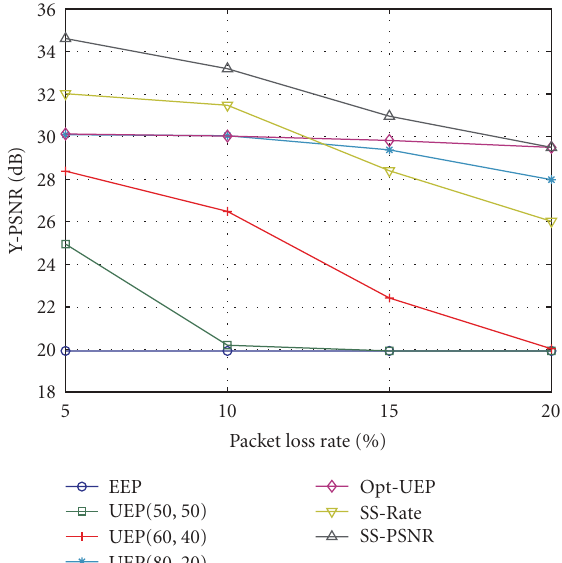
Figure 2: PSNR versus PLR at overall data rate of 1.1 Mbps for the “Paris” sequence—uniform loss.